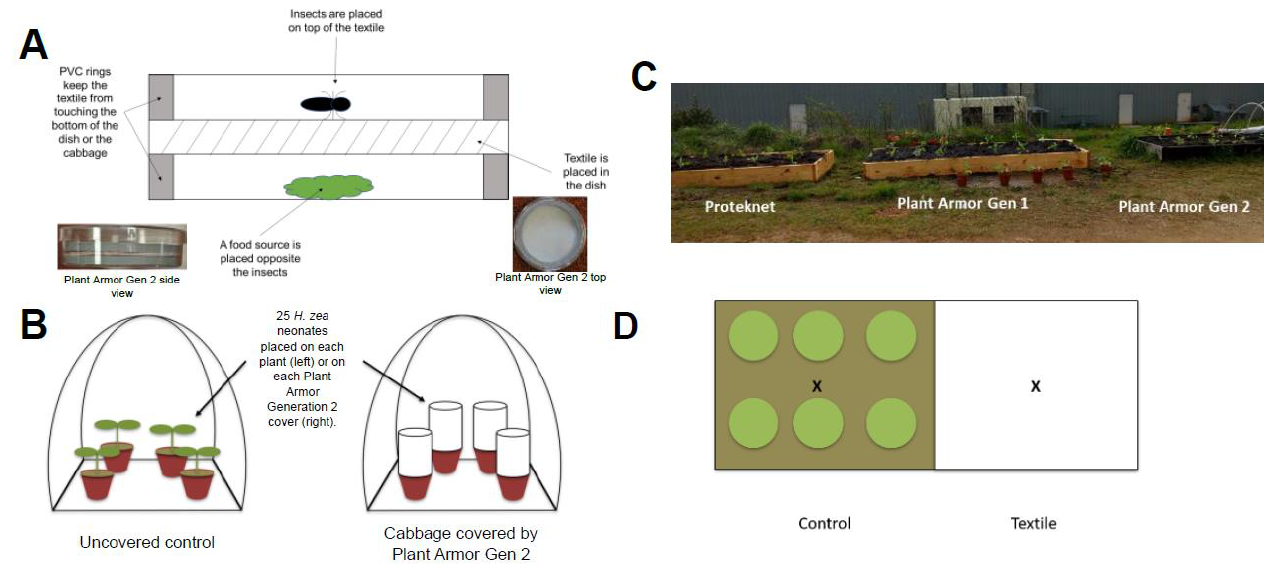
Figure 1. ( A ) Schematic of Petri dish bioassay to measure textile penetration rate for adult Frankliniella fusca (Hinds) and neonates of Helicoverpa zea (Boddie). On bottom left of Figure 1 ( A ) is a side view and bottom right a top view of Plant Armor Generation (Gen) 2 in the Petri dish bioassay. ( B ) Whole plant penetration bioassay architecture with Helicoverpa zea neonates. ( C , D ) Small field plots (wooden, raised beds) to study plant growth. Cabbage (3–4 leaf stage, shown in ( C )) were planted in each raised bed in the pattern shown in ( D ). This pattern was duplicated on the right side (shown as a white background because the plants were covered with Proteknet, Plant Armor Generation (Gen) 1 or Plant Armor Gen 2. ( C ) The plantings before the cover was added to the right half of each plot are shown. The “X” on ( D ) is the location 19 cm from ground level where temperature and humidity measurements were taken for the control (uncovered plants) and treatments (covered plants); control measurements were made only in the Plant Armor Gen 2 plot. Preliminary studies showed no differences in temperature and humidity for the control location between plots.